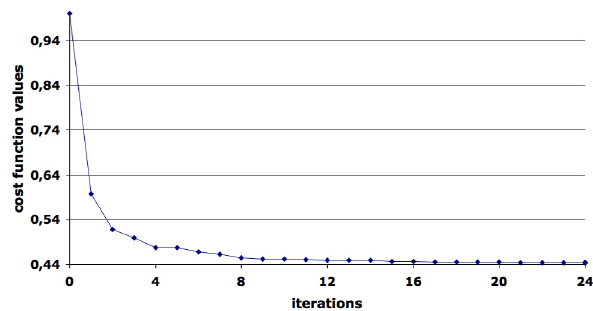
Fig. 7. Initial and optimized (dashed lined) positions of the cooling channels. Fig. 8. Objective function versus